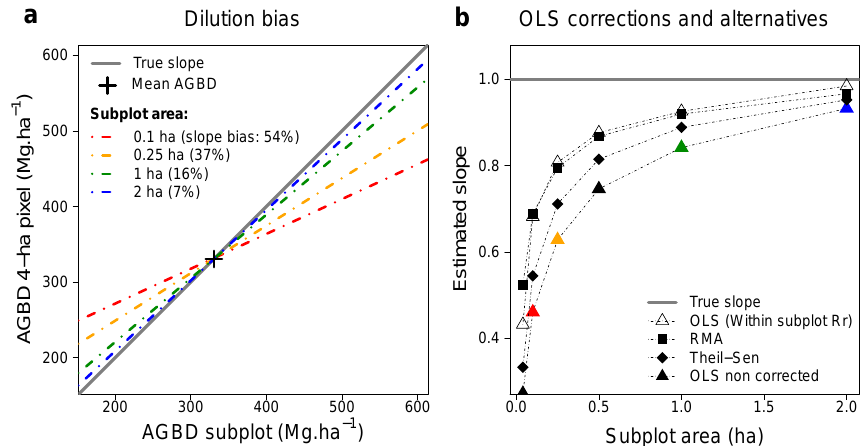
Figure 7. Propagation of field sampling error to remote sensing products: the dilution bias. (a) The mean regression lines obtained from an OLS linear regression between the AGBD estimated within 4ha pixels randomly established in large plots ( n = 60, dependent variable) and variable-size subplots located within these pixels (independent variable) differ depending on subplot areas (see key), and are biased with respect to the true slope of 1 (slope dilution biases associated with each subplot area are provided in parentheses). All the lines cross at the mean AGBD over all sites. (b) Different potential correction methods (see key) result in improved estimates of the slopes, but still retain considerable bias. The points corresponding to the lines in panel (a) are shown with matching colours. The true slope of 1, i.e. the slope that would have been obtained without bias, is illustrated by the solid grey